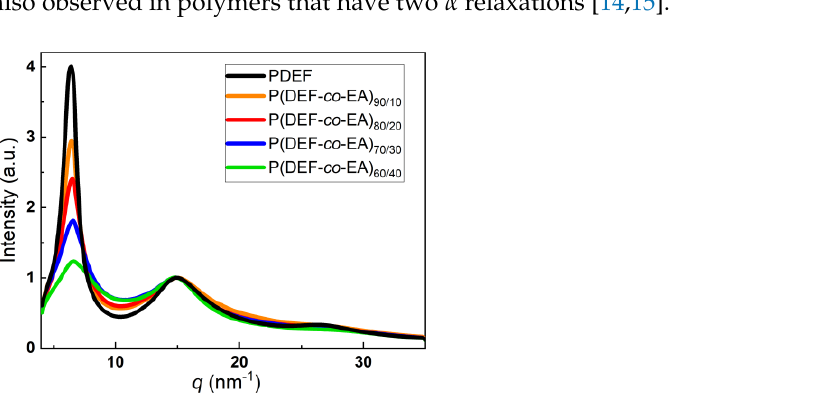
Figure 5. WAXS profiles of P(DEF -co- EA) with different fumarate fractions. The intensity is normal- ized at the peak position at q = 15 nm −1 .